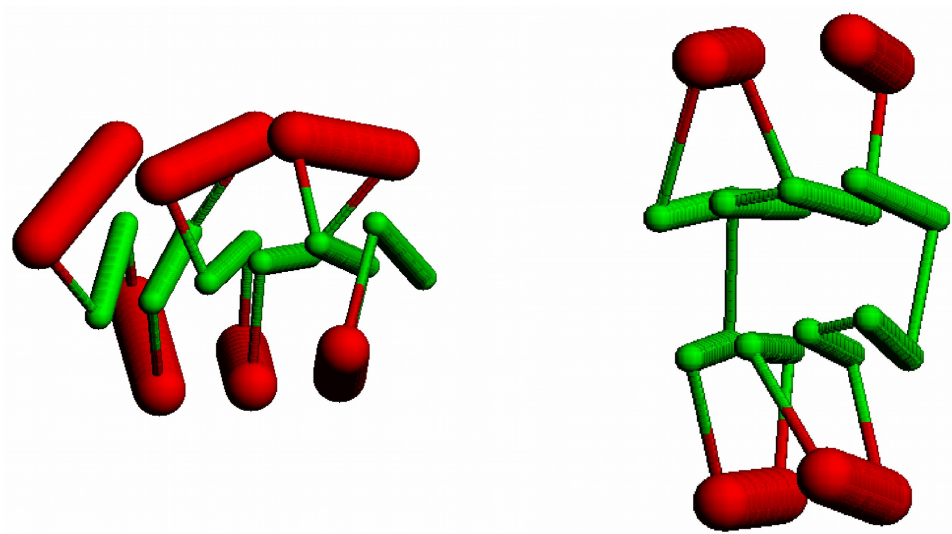
Figure 5. Stick Forms: The “stick” figures derived from a three-layer 3-6-3 (left) and a four-layer 2-4+4-2 (right) Form are shown with strands as green “sticks” and helices as thicker red “sticks”.